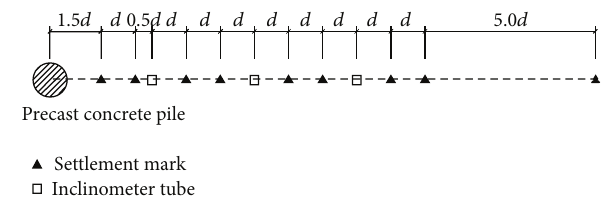
Figure 3: Positions of ground movement monitoring